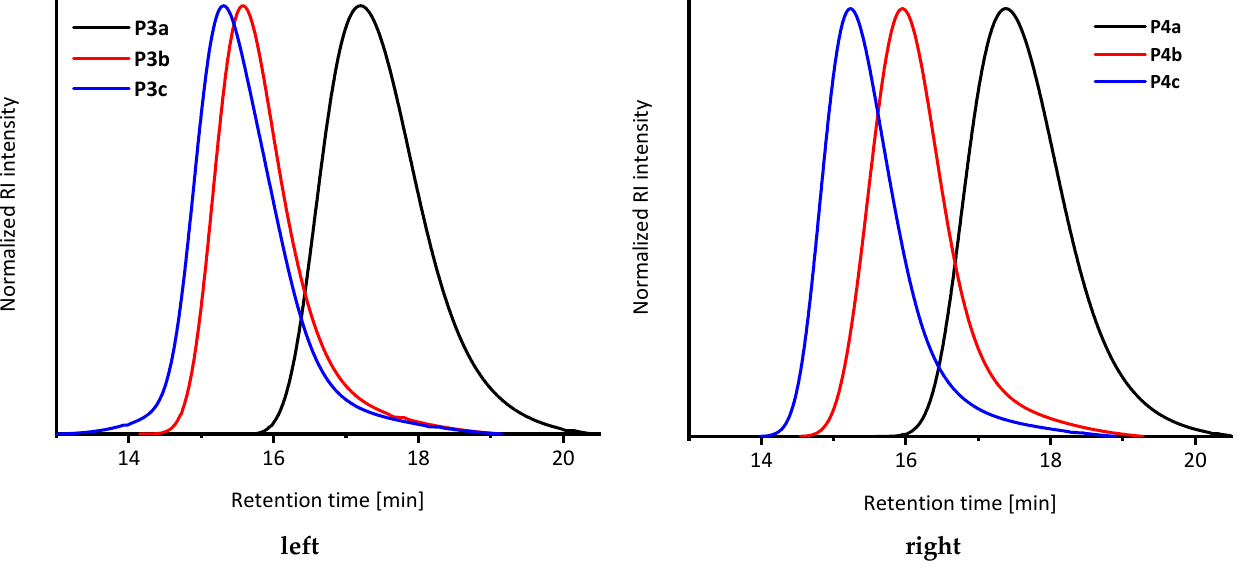
Figure 1. SEC-Elugram of the manually ( P3 , left ) and automated ( P4 , right ) synthesized block copolymer. Black: First reaction step (PS, P3a / P4a ). Red: Second reaction step (PS- b -PBA- b -PS, P3b / P4b ). Blue: Third reaction step (PS- b -PBA- b -PS- b -PBA- b -PS, P3c / P4c ). Standard: Poly(methyl methacrylate) or polystyrene; solvent: chloroform/isopropanol/triethylamine [94/2/4]).